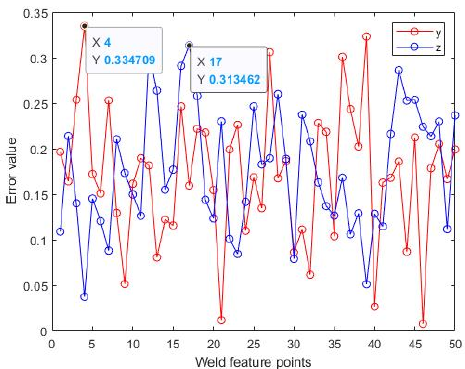
Figure 18. Errors in the weld feature points in the Y and Z directions.